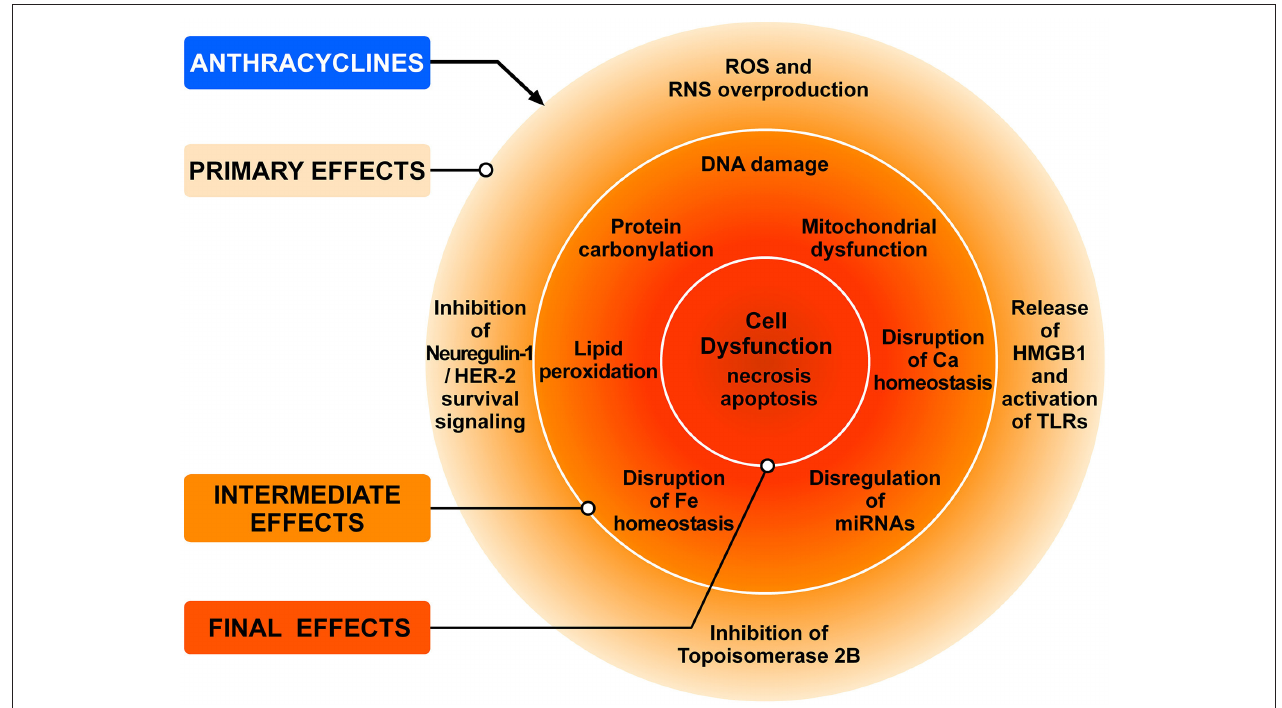
FIGURE 3 | Schematic representation of the main mechanisms of anthracycline-induced injury to cardiac cells. The classic model of anthracycline (ANT) cardiotoxicity involves the generation of ROS by the quinone moiety common to all anthracyclines. ROS and RNS hyperproduction results in damage to DNA, protein carbonylation and lipid peroxidation leading to cellular dysfunction and cardiomyocyte death. ANTs can also bind and block the functions of both topoisomerases 2A (TOP2A) and 2B (TOP2B). Tumor cells express high levels of TOP2A, whereas TOP2B is ubiquitously expressed. Cardiomyocytes express TOP2B, but not TOP2A. ANTs form a complex with TOP2B inhibiting its enzymatic activity. Without functional TOP2B, DNA breaks accrue, leading to the activation of p53 tumor-suppressor protein, mitochondrial dysfunction, and the generation of ROS that result in cardiomyocyte death. Another mechanism underlying doxorubicin-dependent oxidative stress is linked to the ability of the drug to directly interfere with the activity of NADPH oxidase and nitric oxide synthase (NOS). Both NADPH oxidase and NOS can transfer electron from NADPH to doxorubicin, causing the formation of semiquinone doxorubicin (SQ-DOX). SQ-DOX in turn transfers electron to O 2 and generates O − 2 . In the NOS compartment, O − 2 can react with NO to form peroxynitrite (ONOO − ), a powerful oxidant that can generate free radicals. An alternative mechanism by which ANTs exert their cardiotoxic effects is the inhibition of neuregulin-1 (NRG-1)-HER-2 in cardiomyocytes. Doxorubicin also induces necrosis of immune (i.e., macrophages) and cancer cells releasing HMGB1 which activates TLR-2 and TLR-4 in cardiomyocytes and inflammatory cells inducing the release of proinflammatory cytokines. These primary effects induce a plethora of secondary effects in cardiomyocytes (e.g., DNA damage, lipid peroxidation, mitochondrial dysfunction, etc.,) which result in cell dysfunction and death. Modified with permission from Tocchetti et al.